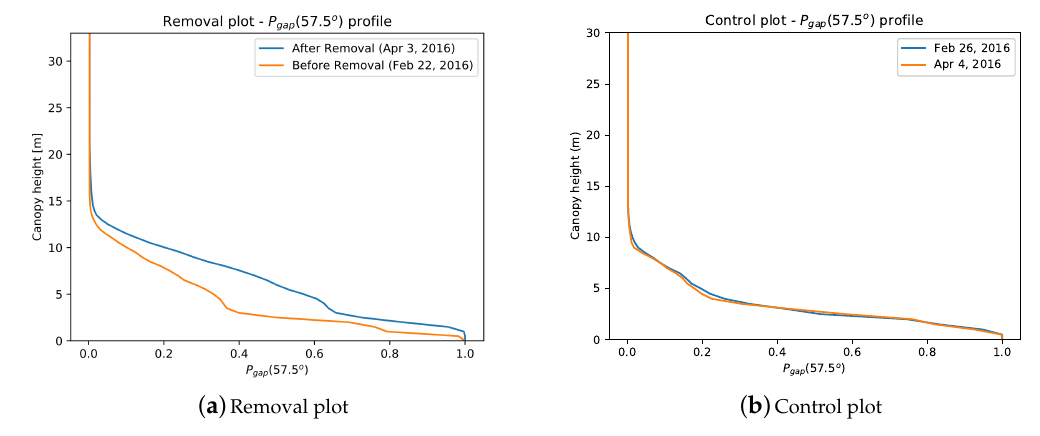
Figure A1. Pgap profile in the hinge region (57.5 ◦